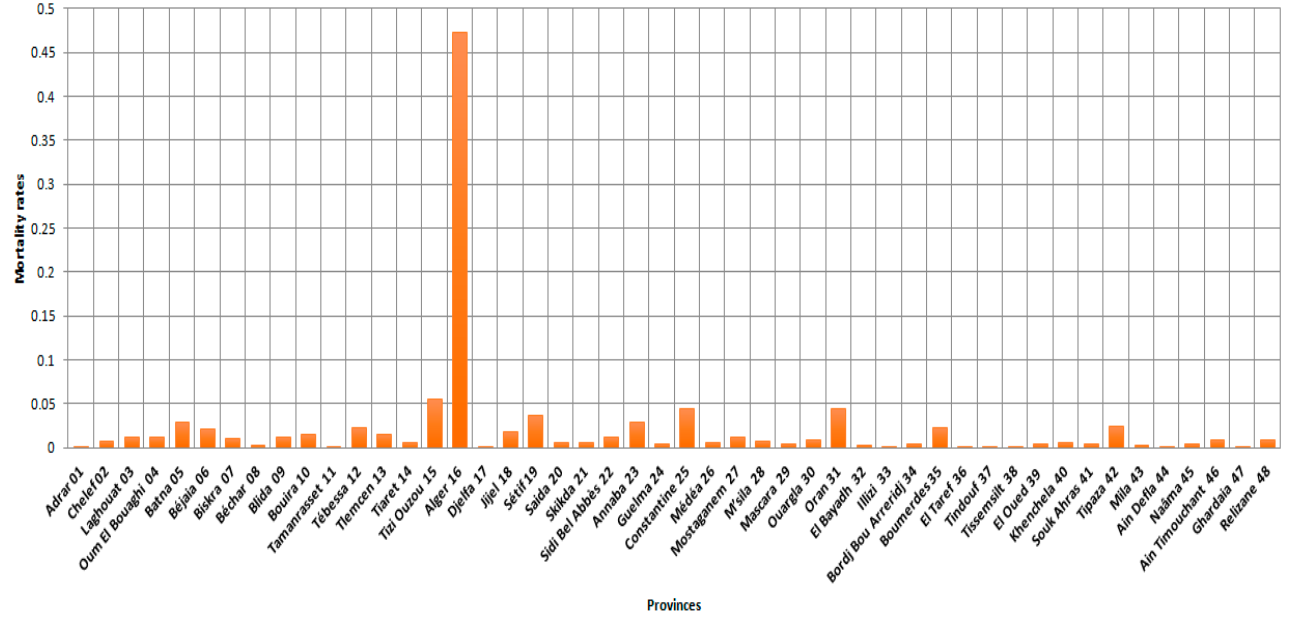
Figure 3. Provincial mortality rates (48 provinces) by COVID-19 between 1 January 2021 and 15 August 2021.